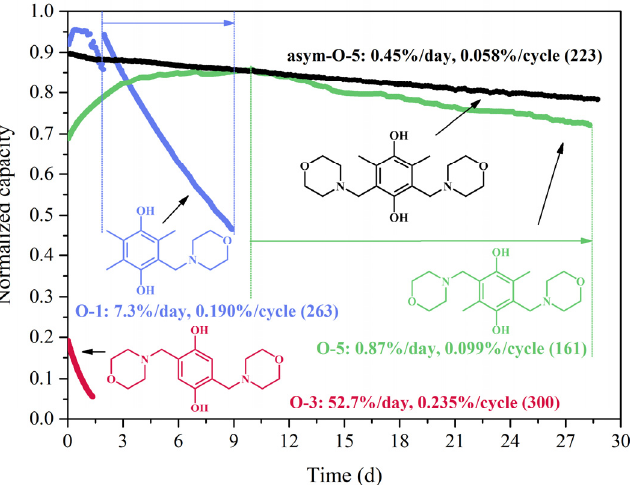
Figure 2. Discharge capacity of the symmetric cells of 0.1 M O-1 , O-3 , O-5 and asym-O-5 in 1 M H 3 PO 4 using the PS cycling method. The y -axis is normalized by dividing the discharge capacity value by its theoretical capacity. The potential is set at 0.3/ − 0.3 V for charge/discharge cycles with cut-off current at 3/ − 3 mA.